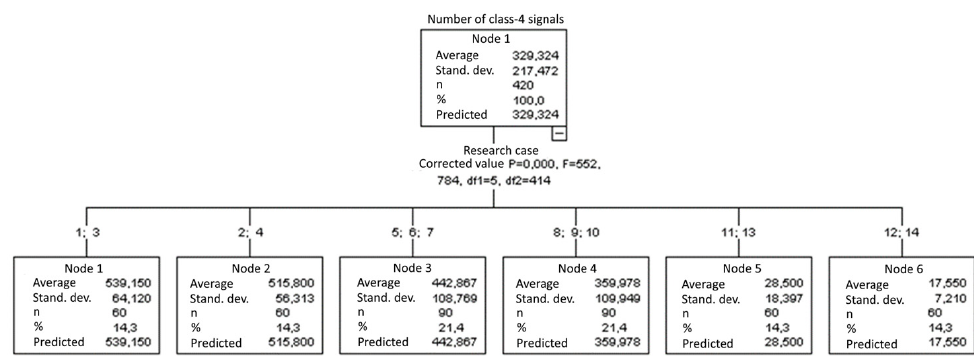
Figure 25. Classification tree for the number of class-4 signals.